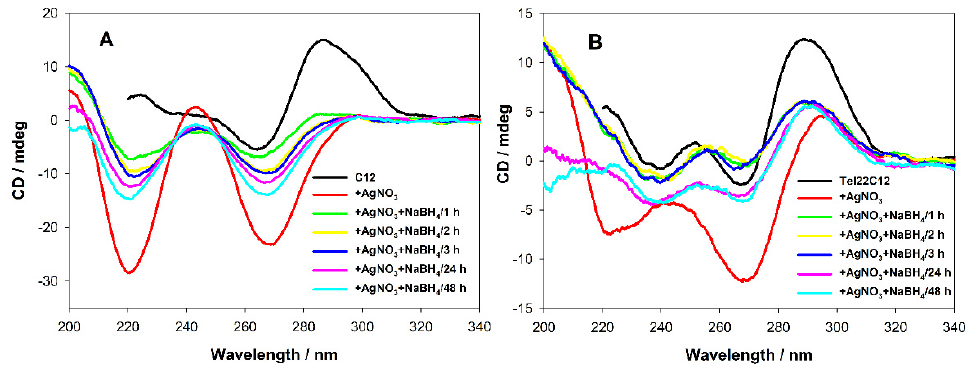
Figure 3. Circular dichroism spectra of studied systems before and after formation of C12AgNCs ( A ) or Tel22C12-AgNCs ( B ). Conditions: 2 μ M probe, 10 mM Tris-acetate (pH = 7.5), [Ag + ] = [BH 4 ¯ ] = 24 μ M.